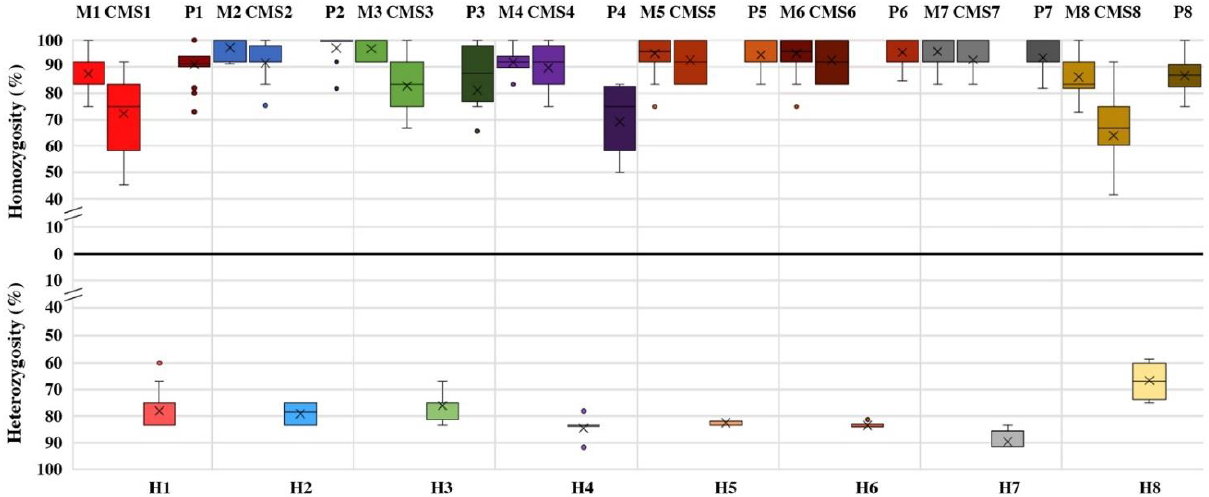
Figure 1. Box plot of the median observed homozygosity (top) and observed heterozygosity (bottom) related to, respectively, parental lines (M, maintainer; cytoplasmic male-sterile, CMS; P, pollen donor) and F1 hybrid (H) offspring for each fennel breeding scheme. Each population is labeled with different colors (the CMS and M lines of each variety have the same color tone whereas P lines are represented by a darker color and H hybrids show a lighter color). The second and third quartiles are marked inside the square and are divided by a bar (median). The cross (×) within each box represents the mean value. Dots show outlier samples.